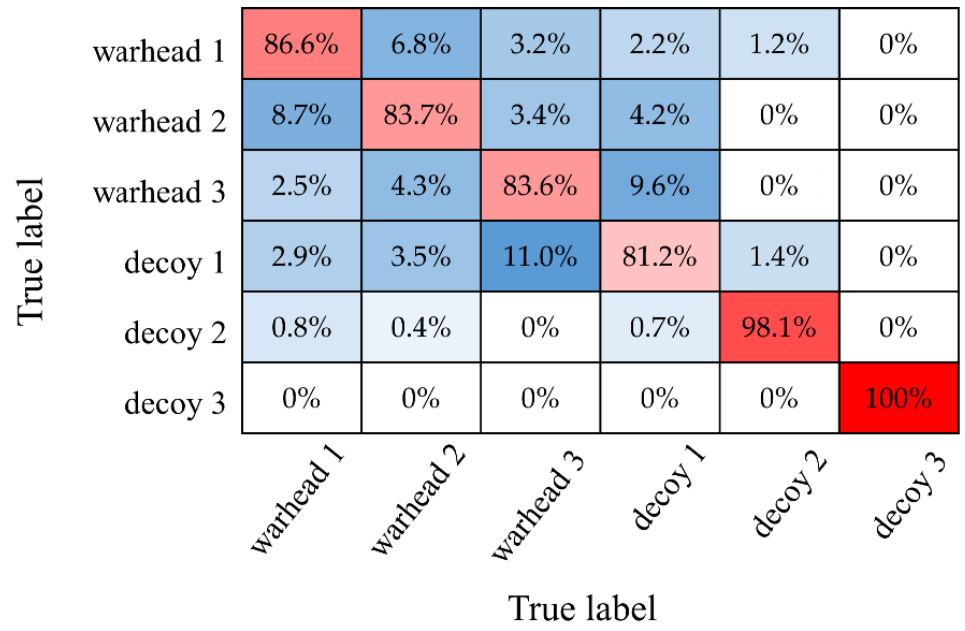
Figure 12. Confusion matrix of our method with the SNR of −10 dB.